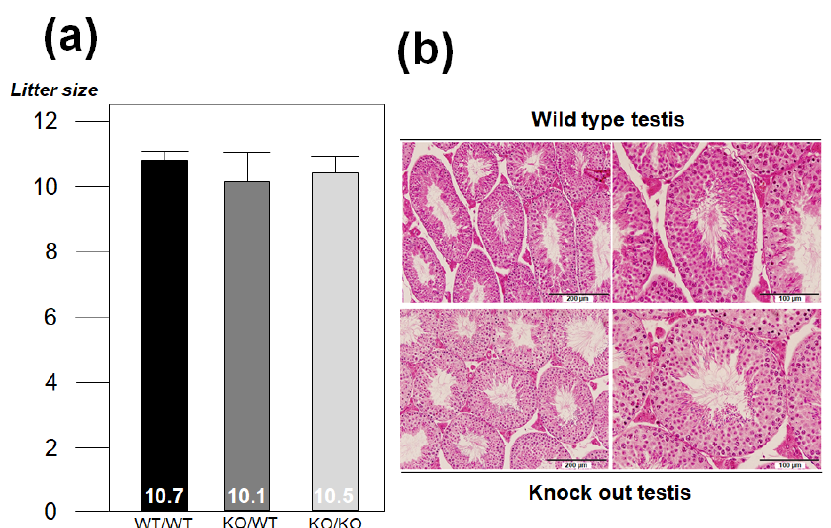
Figure 4. The loss of VSIG1 does not affect spermatogenesis or the rate of fertilization. ( a ) Mean litter size from VSIG1 KO and WT male mice. ( b ) Hematoxylin and eosin staining of the mouse testis in wild-type (WT) and VSIG1 knockout (KO)